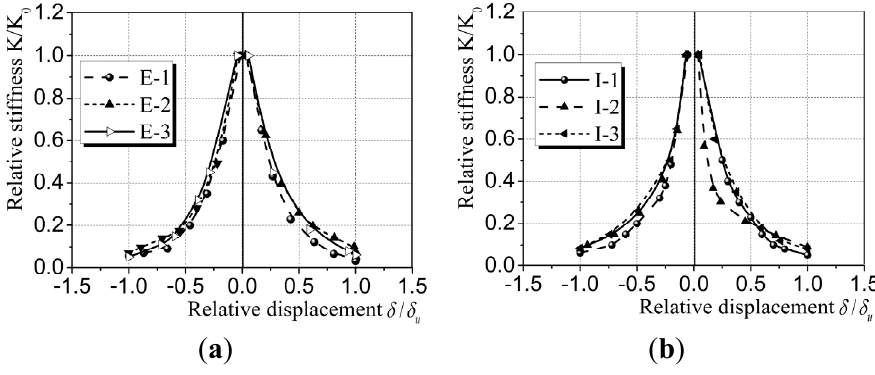
Figure 14. Comparison of stiffness degradation for CEW/CIW. ( a ) CEW; ( b )